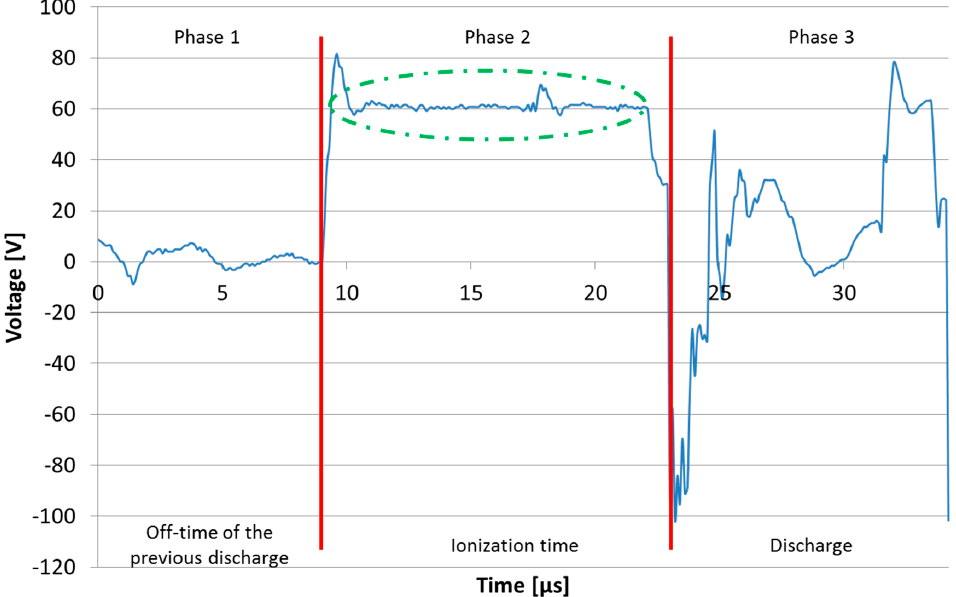
Figure 1. Voltage signal evolution during a single discharge in an industrial wire electrical discharged machining (WEDM) operation.